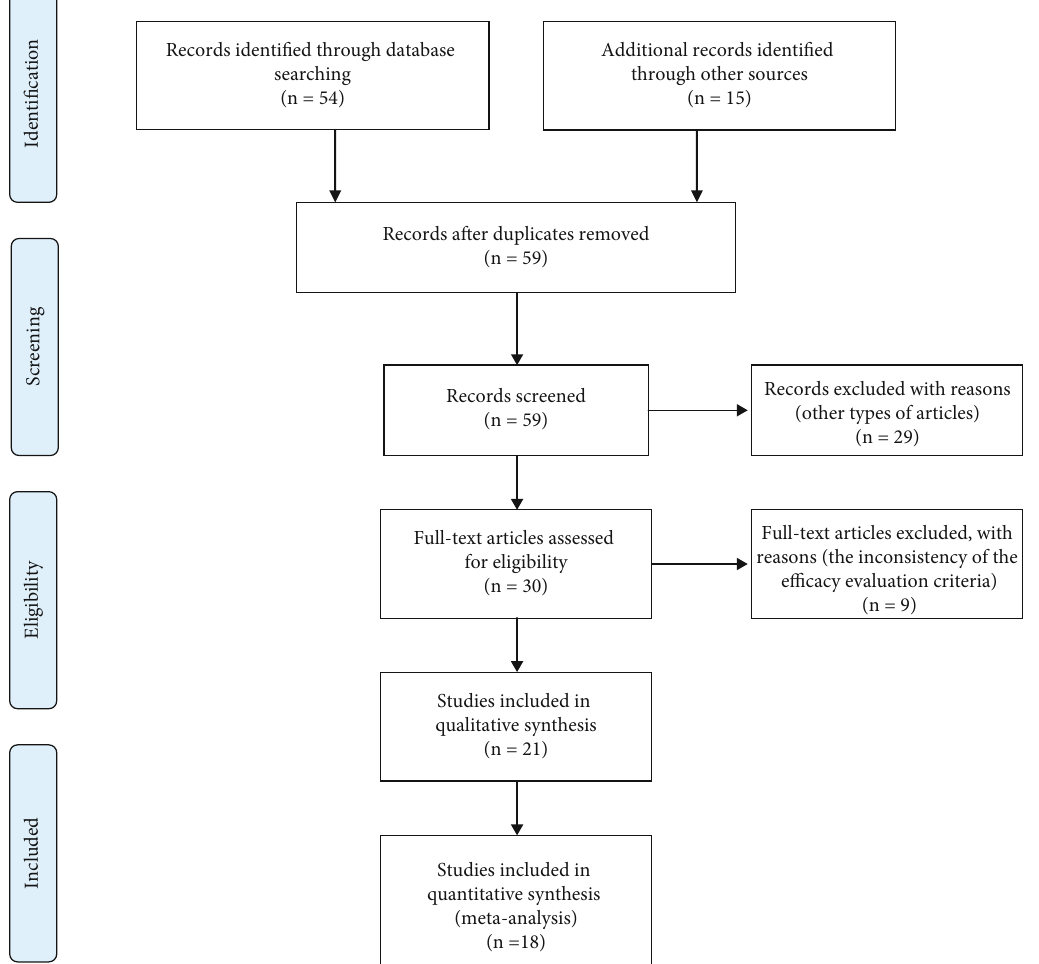
Figure 1: Flow diagram of literature search and study selection